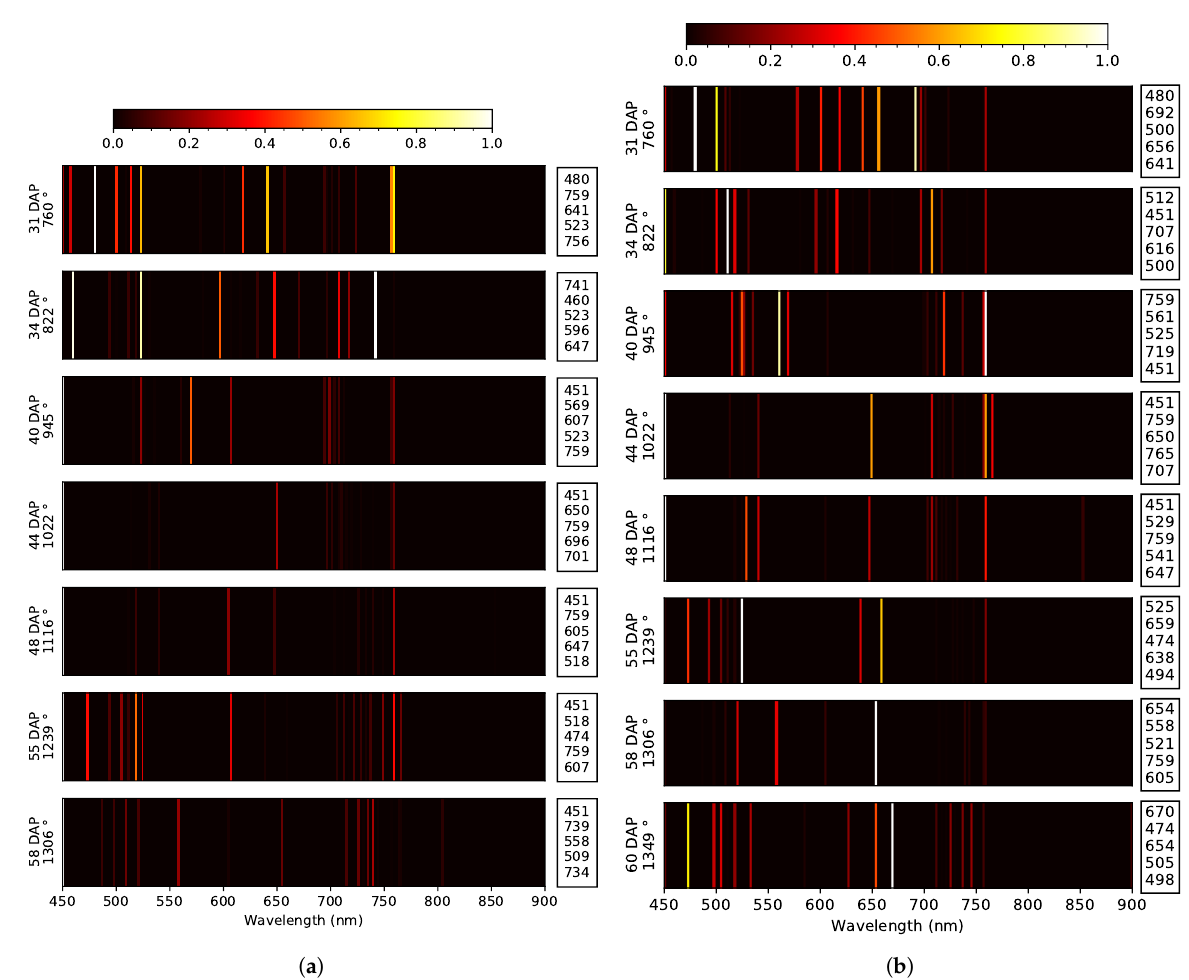
Figure 14. Snap bean pod weight the 2020 data set average rankings across all four optimization models for SAM model at ( a ) the early harvest stage and ( b ) the late harvest stage. The corresponding days after planting (DAP) and heat unit for the collected data are shown to the left of each ranking belt, while the top five features, with the first one having the highest score, are listed to the